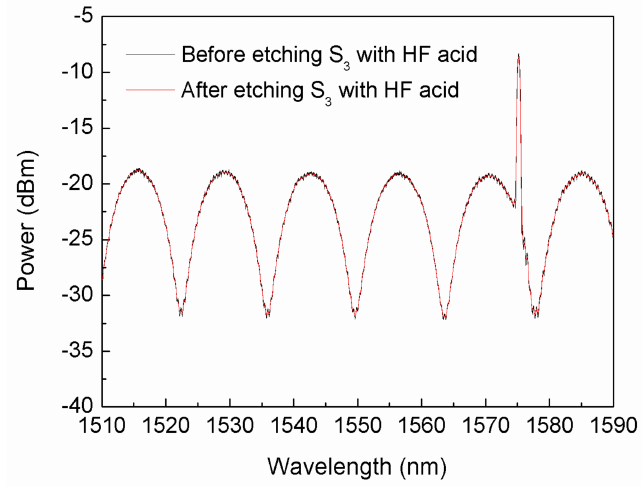
Figure 5. Interference spectrum of the fiber-optic FP gas pressure sensor with FP interferometer and FBG.